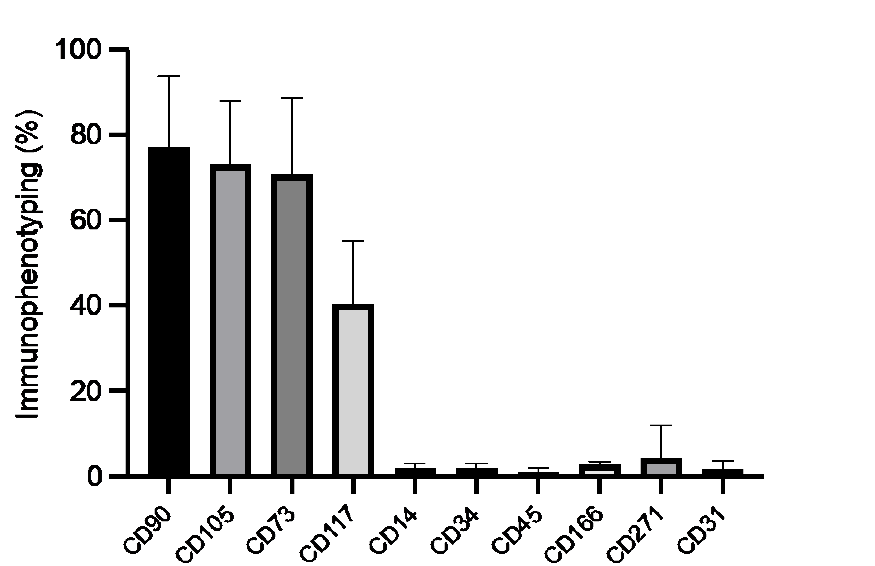
Figure 1. Immunophenotyping of SM-derived cells. SM-derived cells showed abundant CD90, CD105, and CD73 (mesenchymal) expression and lower CD117, CD34, CD45 (hematopoietic), CD271 (neural), and CD31 (endothelial) expression. Values represent the mean ± standard deviation of independent experiments ( n = 6).